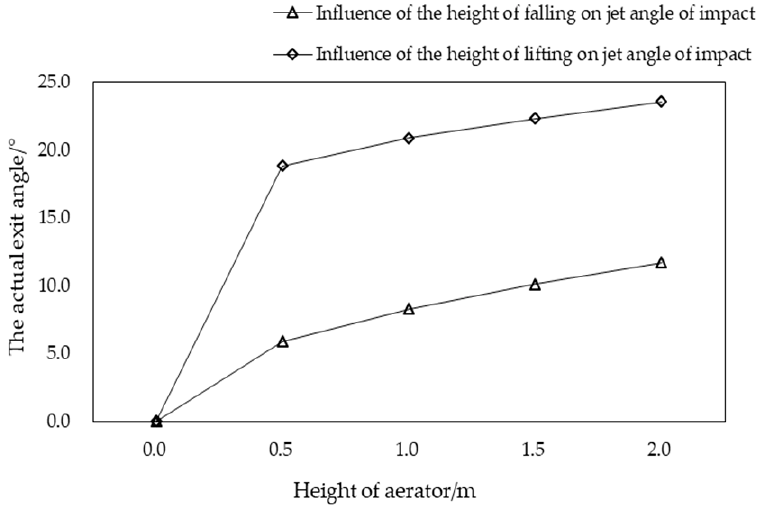
Figure 4. Relationship between different tip and jet impact angle.